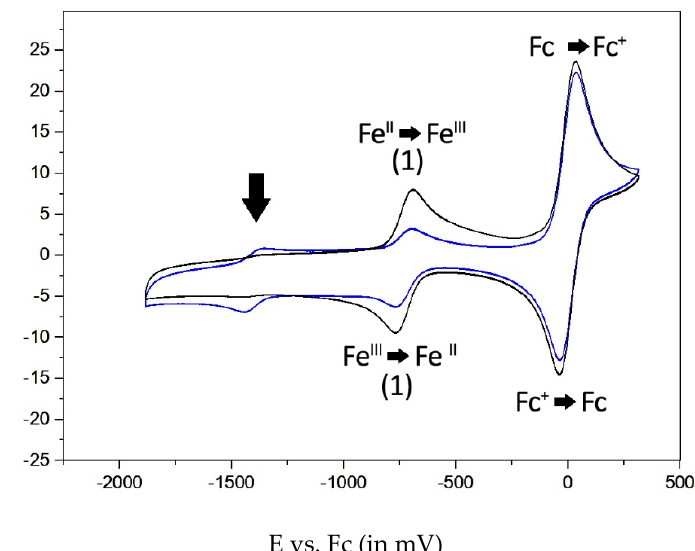
Figure 11. Voltammograms of compound 1 (1 mM) in DMSO vs. ferrocene (Fc, 2 mM) with traces of oxygen present (in blue). The oxidation peak at − 716 mV (vs. Fc) is almost diminished (in blue) and an additional signal (black arrow) is shown at − 1395 mV (vs. Fc). After flushing with argon, the additional signal at − 1395 mV (vs. Fc) is reduced and the monomeric iron(III/II) signal occurs as a reversible redox pair (in black).